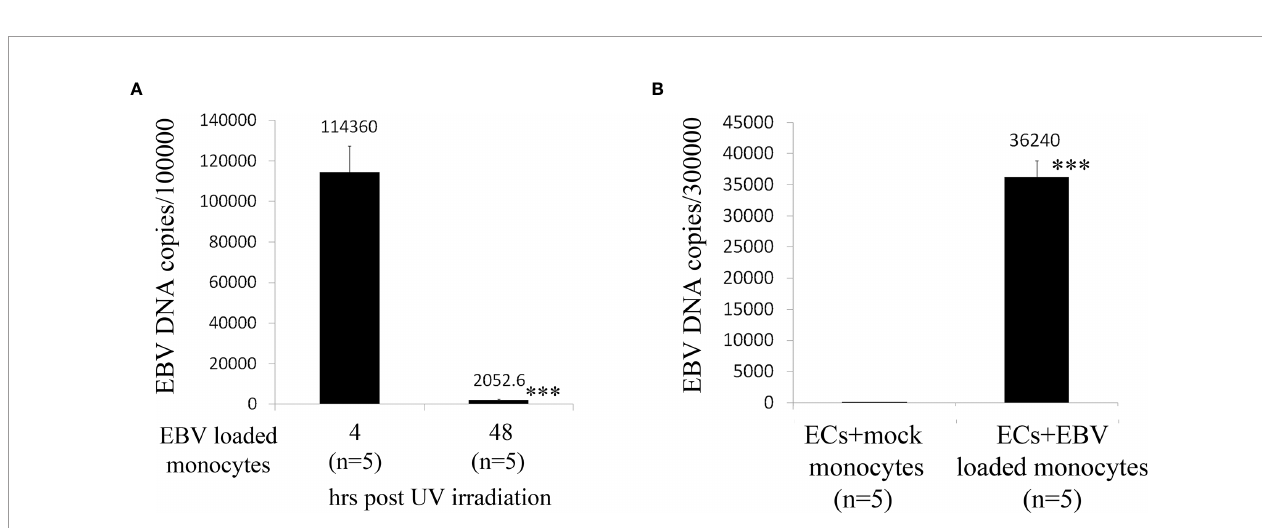
FIGURE 3 | Cell viability of human monocytes after exposure of UV irradiation treatment. (A, B) Freshly isolated human monocytes from healthy donors (HDs) were irradiated with high dose of UV and then re-suspended in virus preparations (EBV/p2089 loaded monocytes) or in medium without virus preparations (mock loaded monocytes). Cell viability was evaluated by trypan blue dye exclusion procedure. Bars represent mean ± S.E.M. from fi ve different HDs. p-values (p<0.0001) calculated using two-tailed T-test. ***p<0.0001.